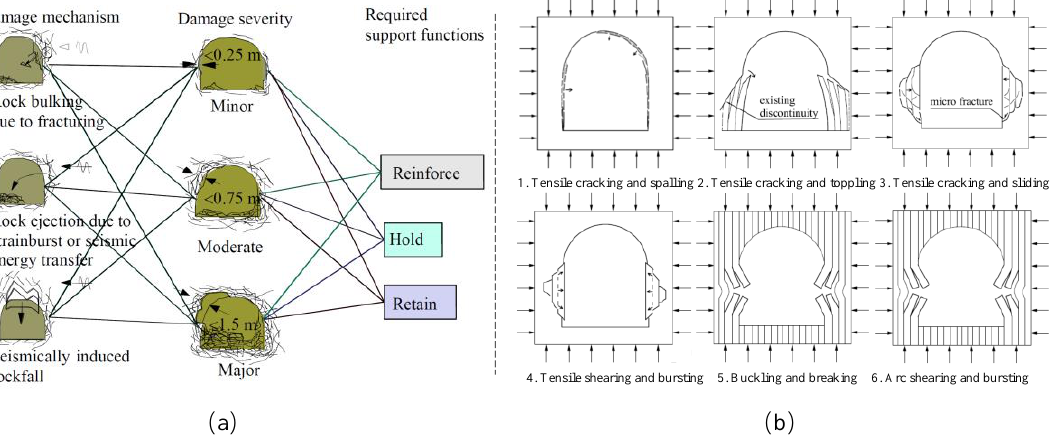
Figure 3. Rockburst types of classification: ( a ) rockburst damage mechanism, damage severity and required support functions (from [30]); ( b ) six geomechanical types of rockburst adapted from [28].